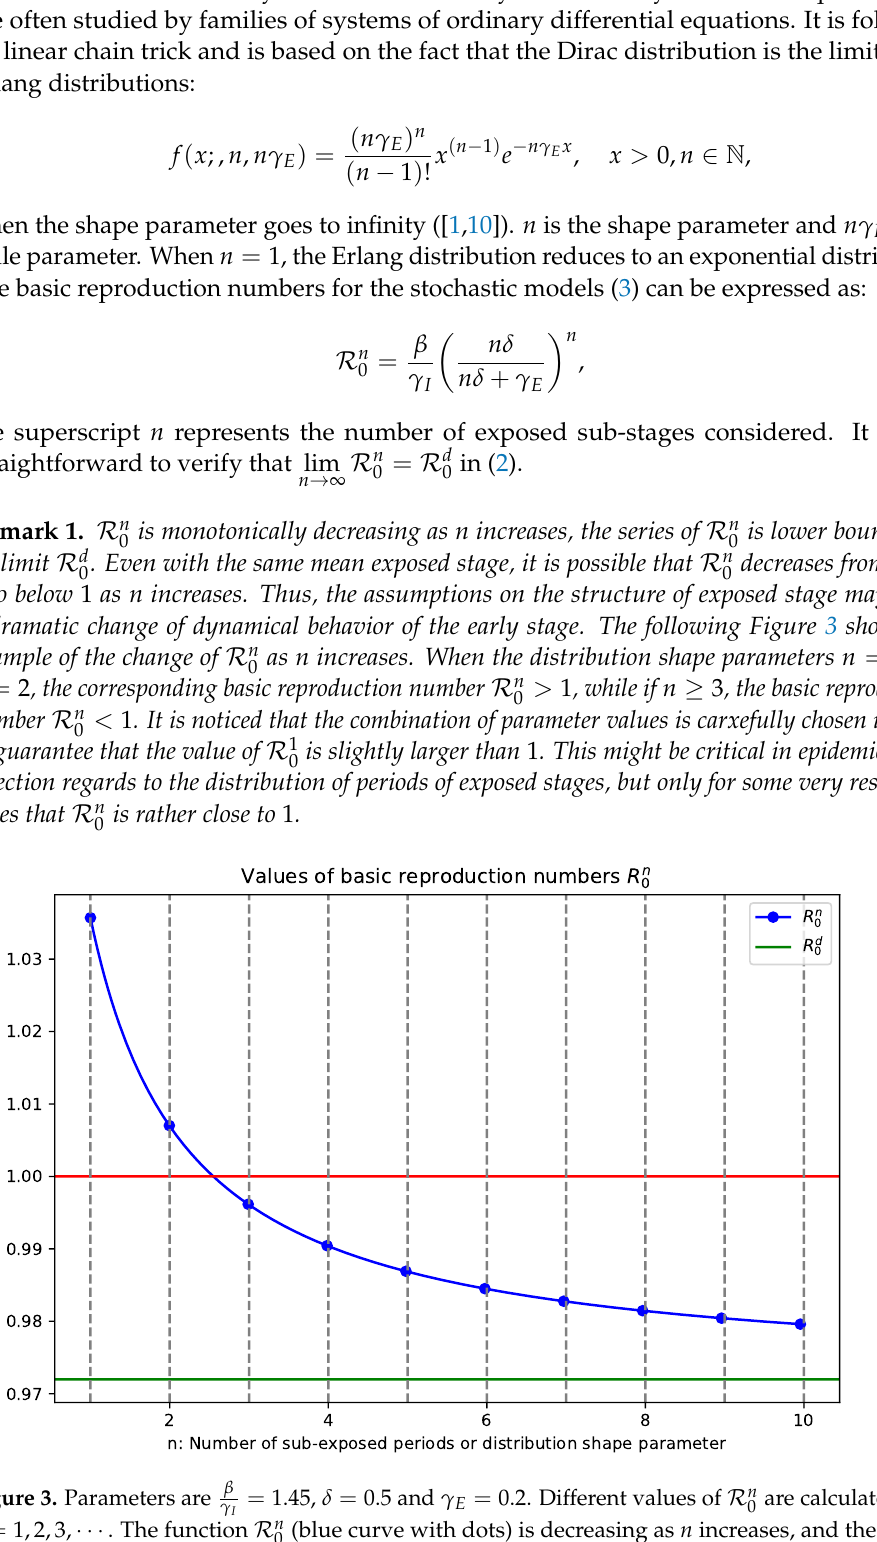
10 are calculated with 0